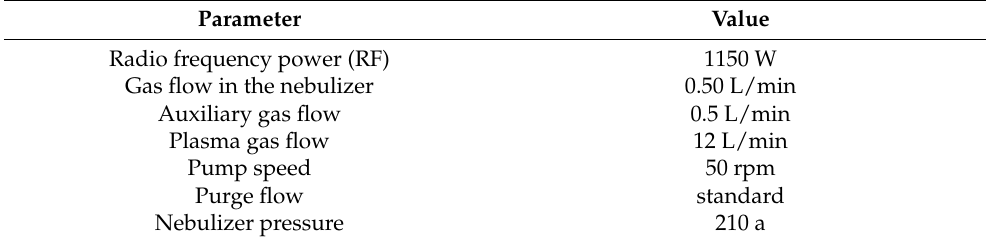
Table 1. ICP-OES working parameters.